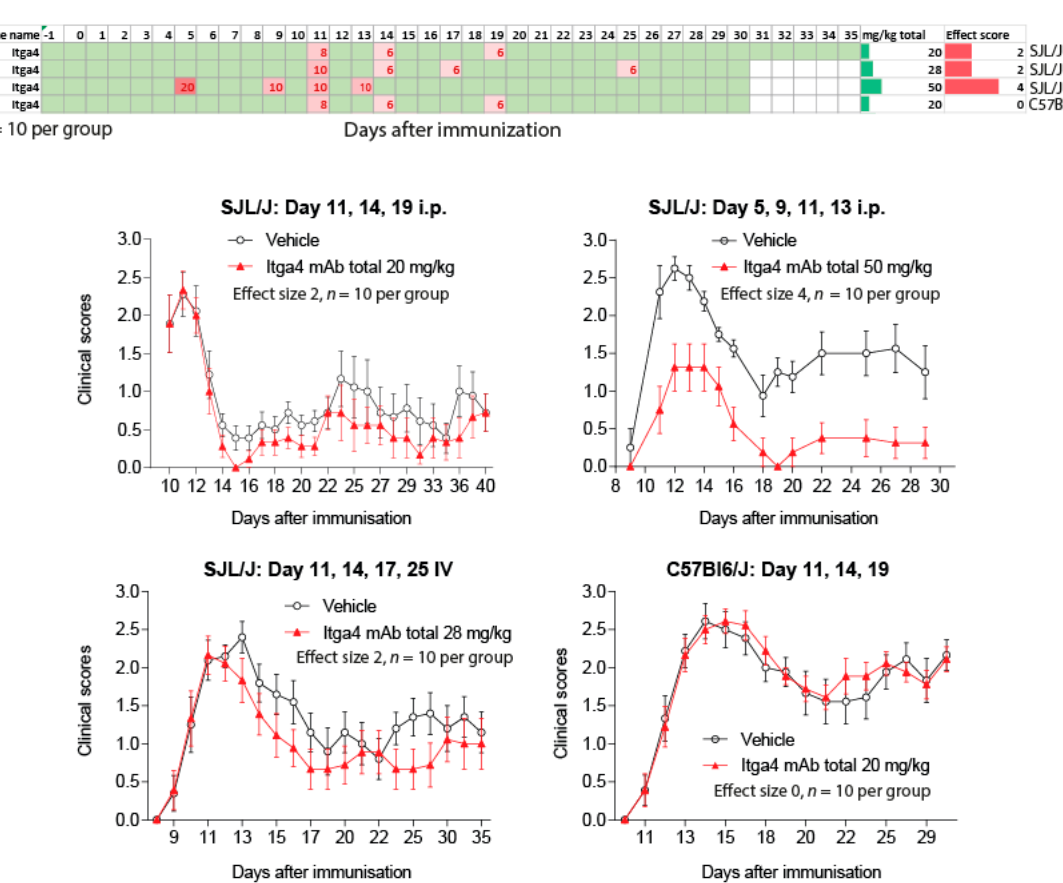
Figure 6. Time courses of EAE scores in SJL/J or C57BL6 mice treated with anti-Itga4 or placebo according to the schedules and doses presented in the figure. The single doses ranged from 6–20 mg/kg. Each experiment comprised 10 mice per treatment group and data are the mean ± sem (standard error of mean). The effect size scores in SJL/J was 2 (mild reduction) to 4 (substantial). There was no effect in C57BL6 mice. The top panel shows the schedules.